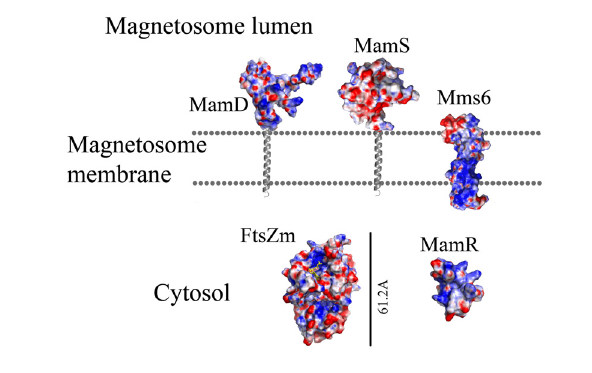
FIGURE 7 | Protein structure predictions that are involved in controlling the size and shape of the magnetite particles. Negative charges are in red and positive charges are in blue. Predictions of anchoring transmembrane helices are in gray. Black bars define the protein size in